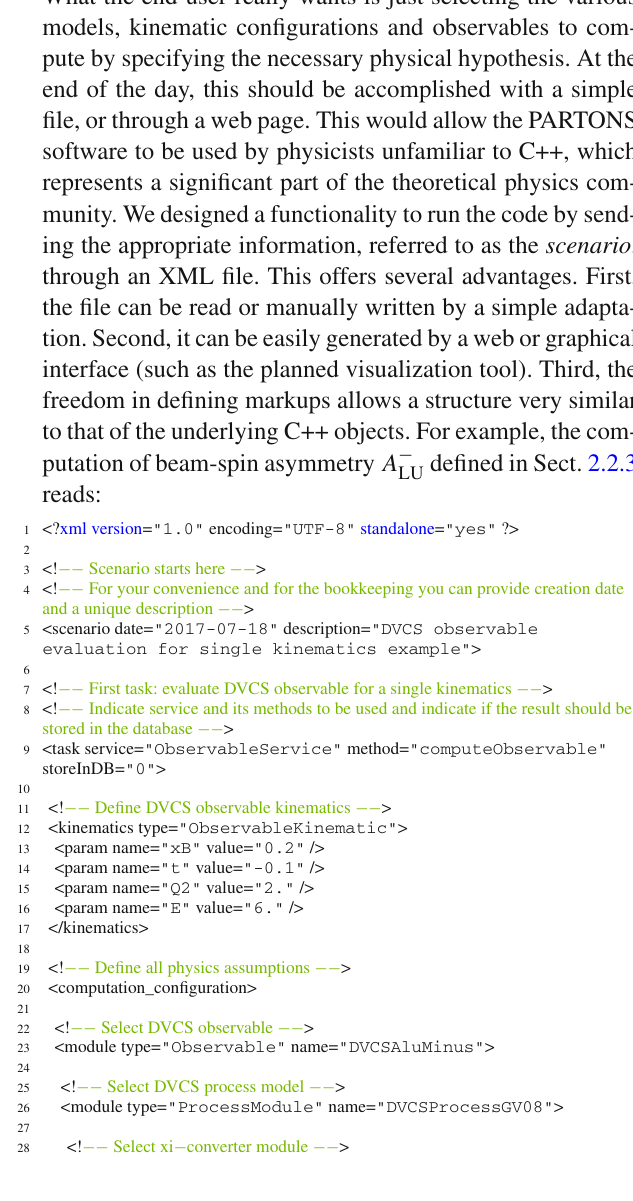
provides several functions that hide the complexity